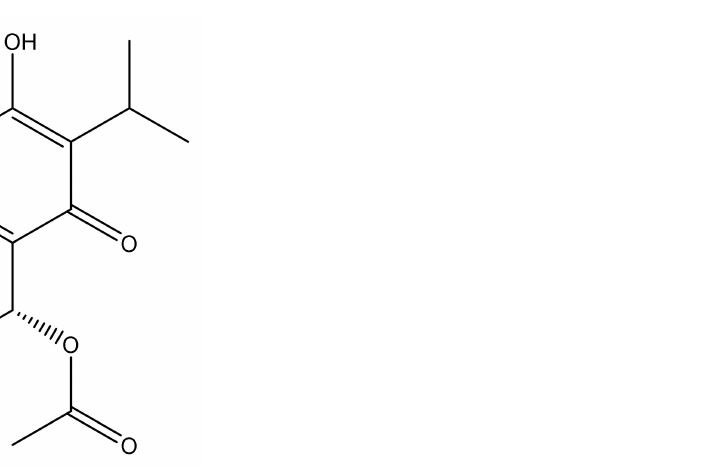
Figure 3. Chemical structure of 7 α -acetoxy-6 β -hydroxyroyleanone isolated after bioactivity-guided fractionation from the DCM extract of P. zeylanicus